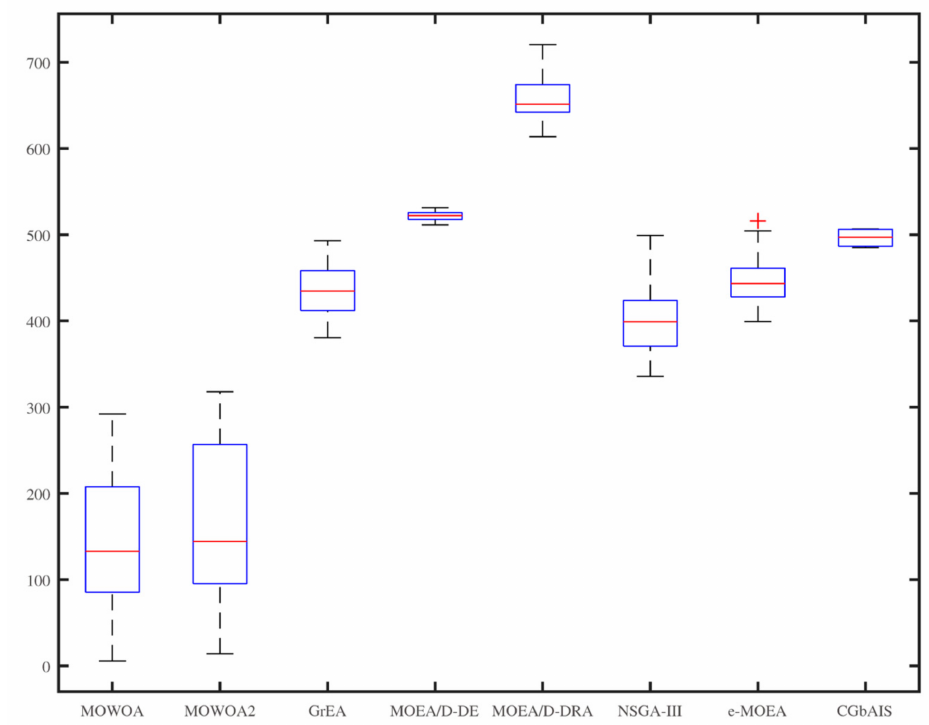
Figure 8. Energy consumption of the different algorithms when the user number is